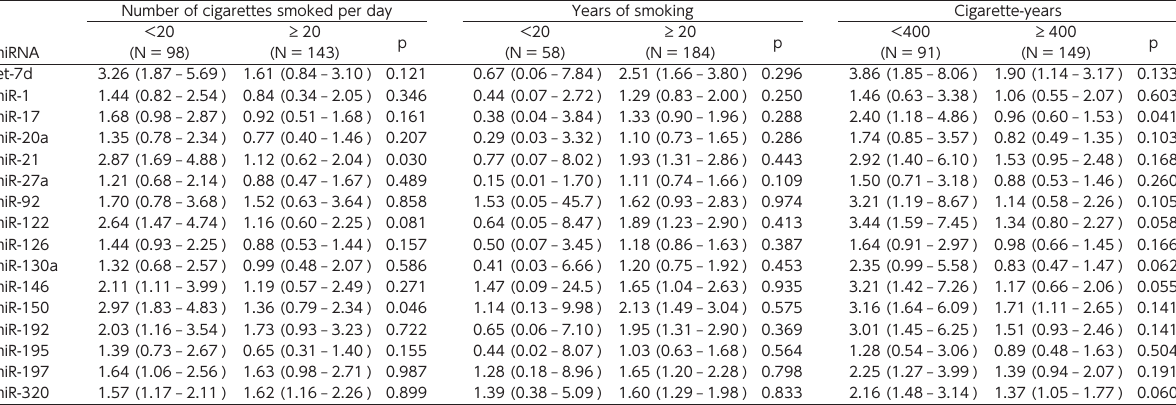
Table 4. Adjusted a relative serum miRNA levels according to number of cigarettes smoked per day, years of smoking, and cigarette-years among current smokers Number of cigarettes smoked per